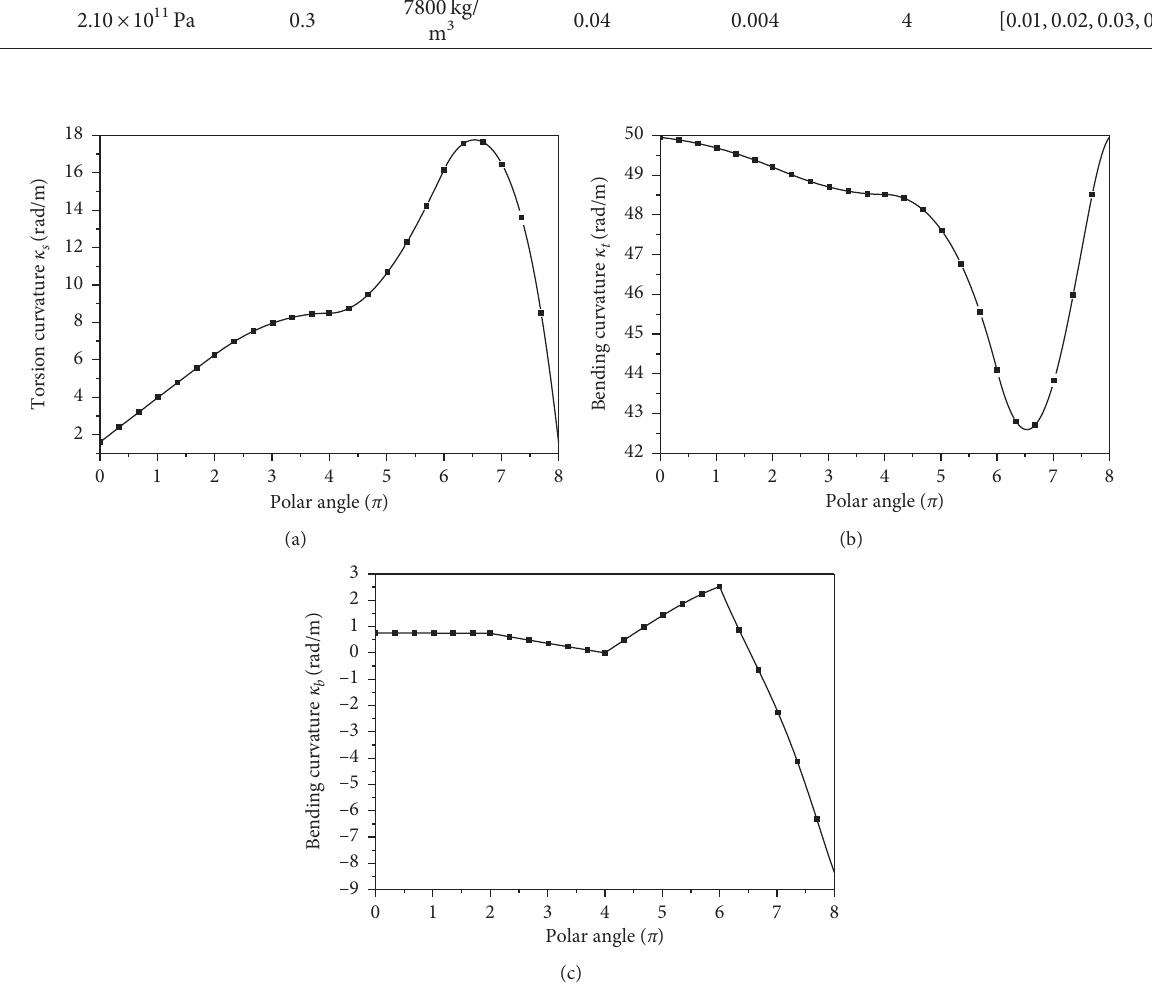
Figure 5: Curvature of the variable pitch spring in the initial configuration. (a) The torsion curvature κ The bending curvature κ t of the spring in the initial state. (c) The bending curvature κ b of the spring in the initial state.